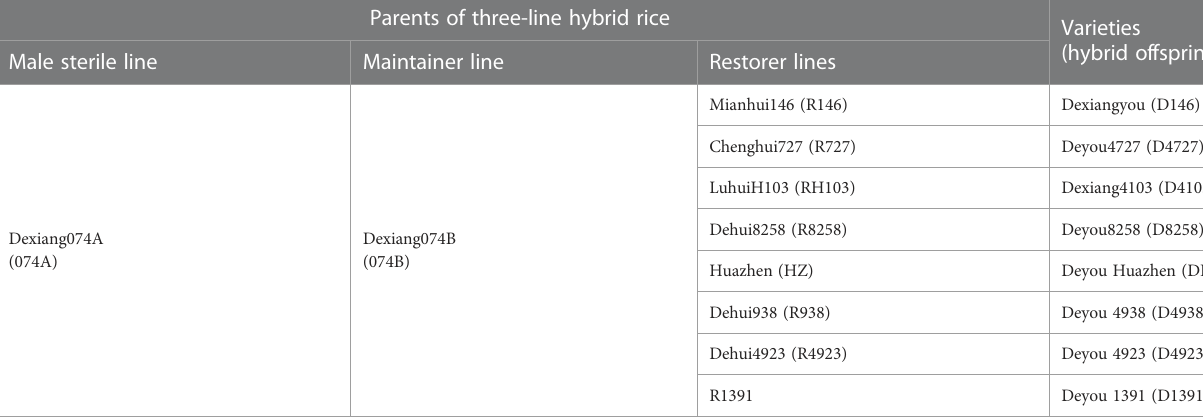
TABLE 1 Genetic relationships between sterile, maintainer, restorer lines, and